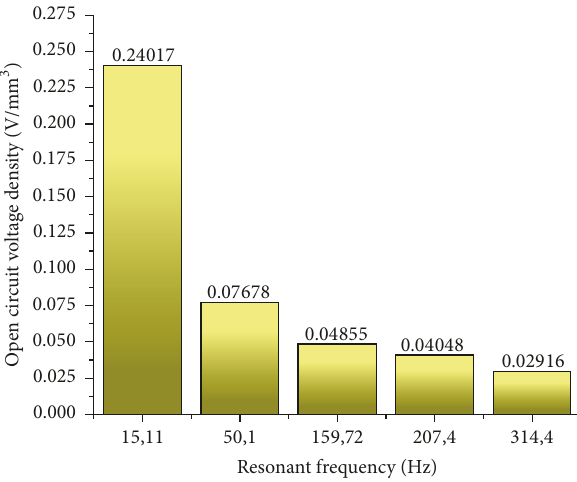
Figure 14: Open circuit voltage density